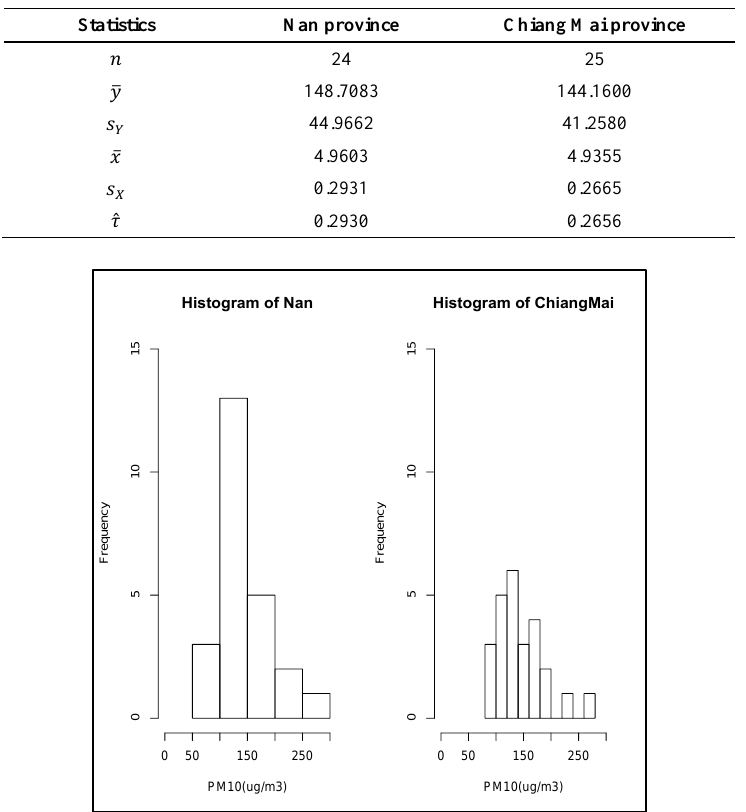
Table 5. Sample statistics of the Nan and Chiang Mai provinces.